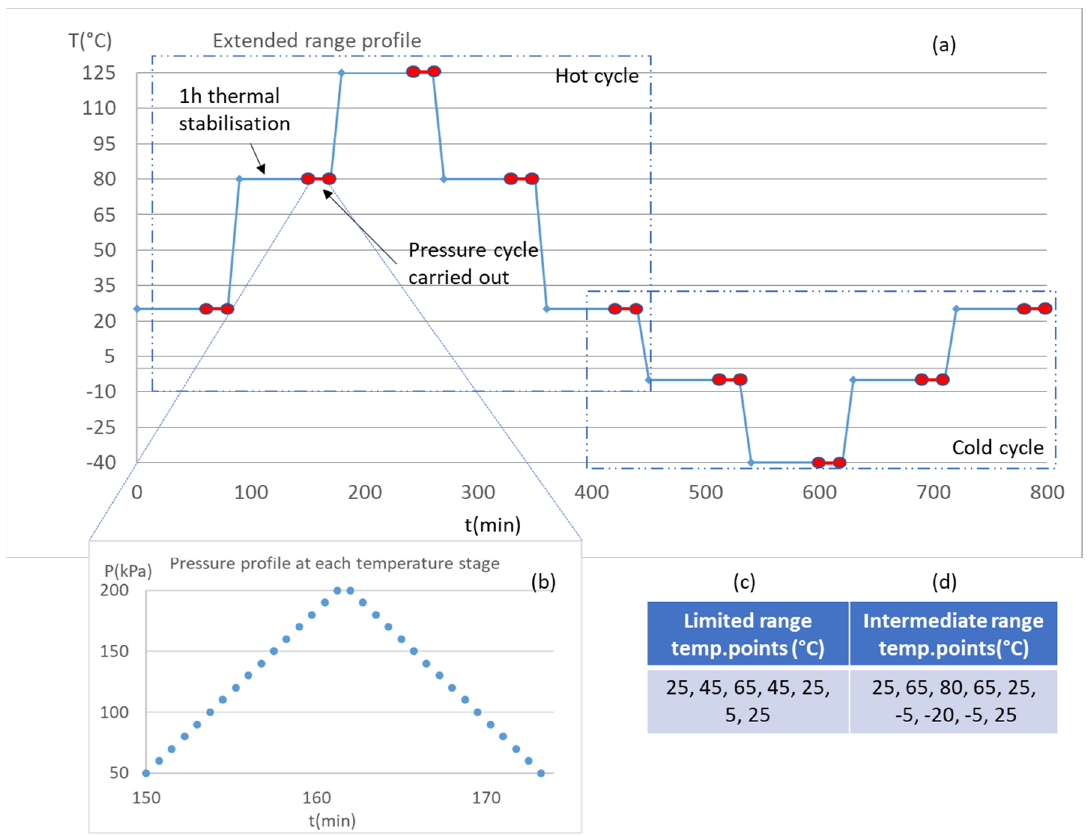
Figure 4. Temperature and pressure cycles applied to the samples: (a) the − 40 to 125°C extended range temperature profile; (b) the 50 to 200 kPa pressure cycle applied at each temperature step within the thermal cycle; and (c,d) temperature set points for the limited and intermediate thermal cycles.